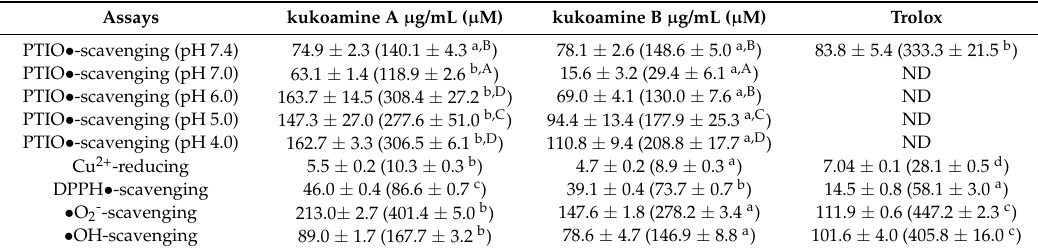
Table 1. The IC50 values of kukoamine A and B in various antioxidant assays.